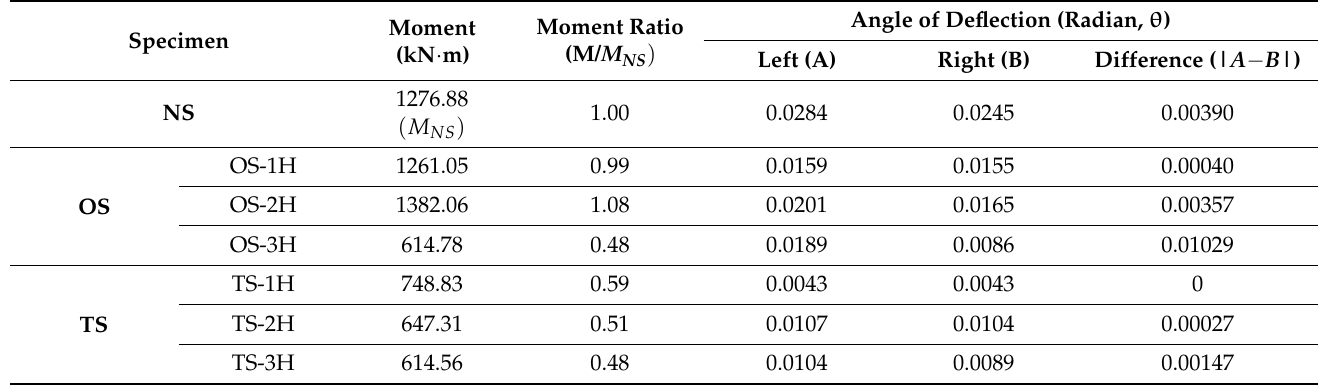
Table 12. Result of moment–deflection